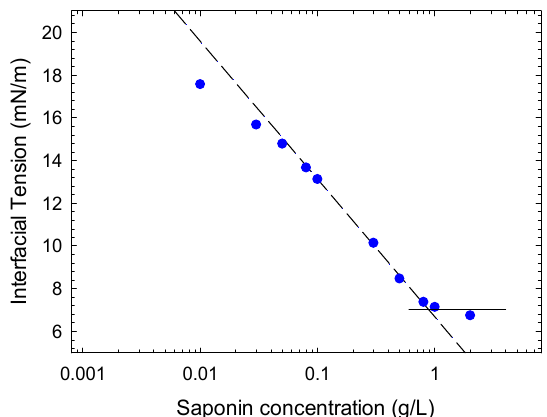
Figure 2. Interfacial tension versus time during the adsorption of saponin at water/Medium Chain Triglyceride (MCT) interface, for different concentrations of saponin in water: from 0.01 to 1 g/L.